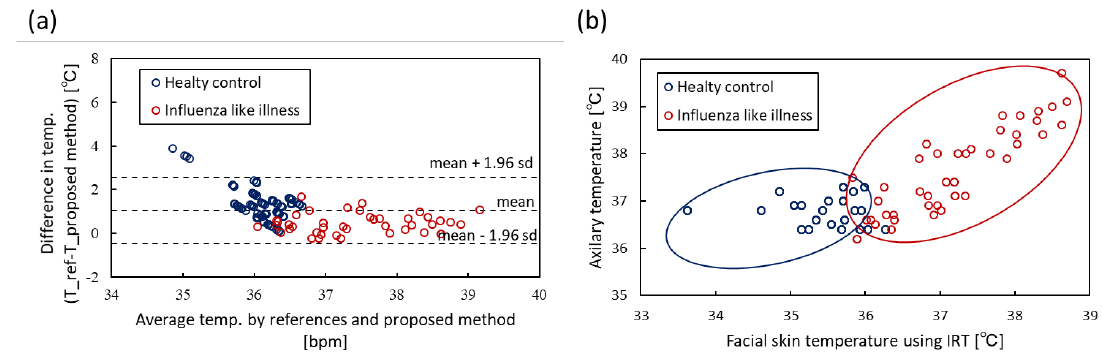
Figure 10. Bland–Altman plots and scatter plots of body temperature obtained by IRT sensor and electric thermometer. ( a ) Bland–Altman plot. ( b ) Scatter plot.